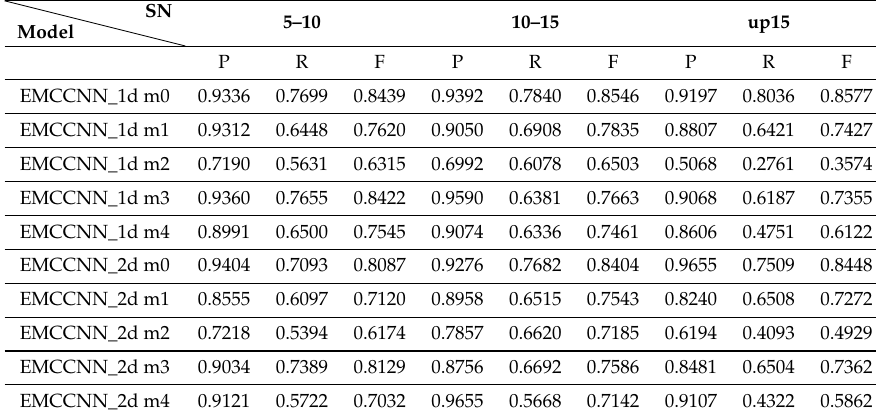
Table 4. Fine Classification Results of